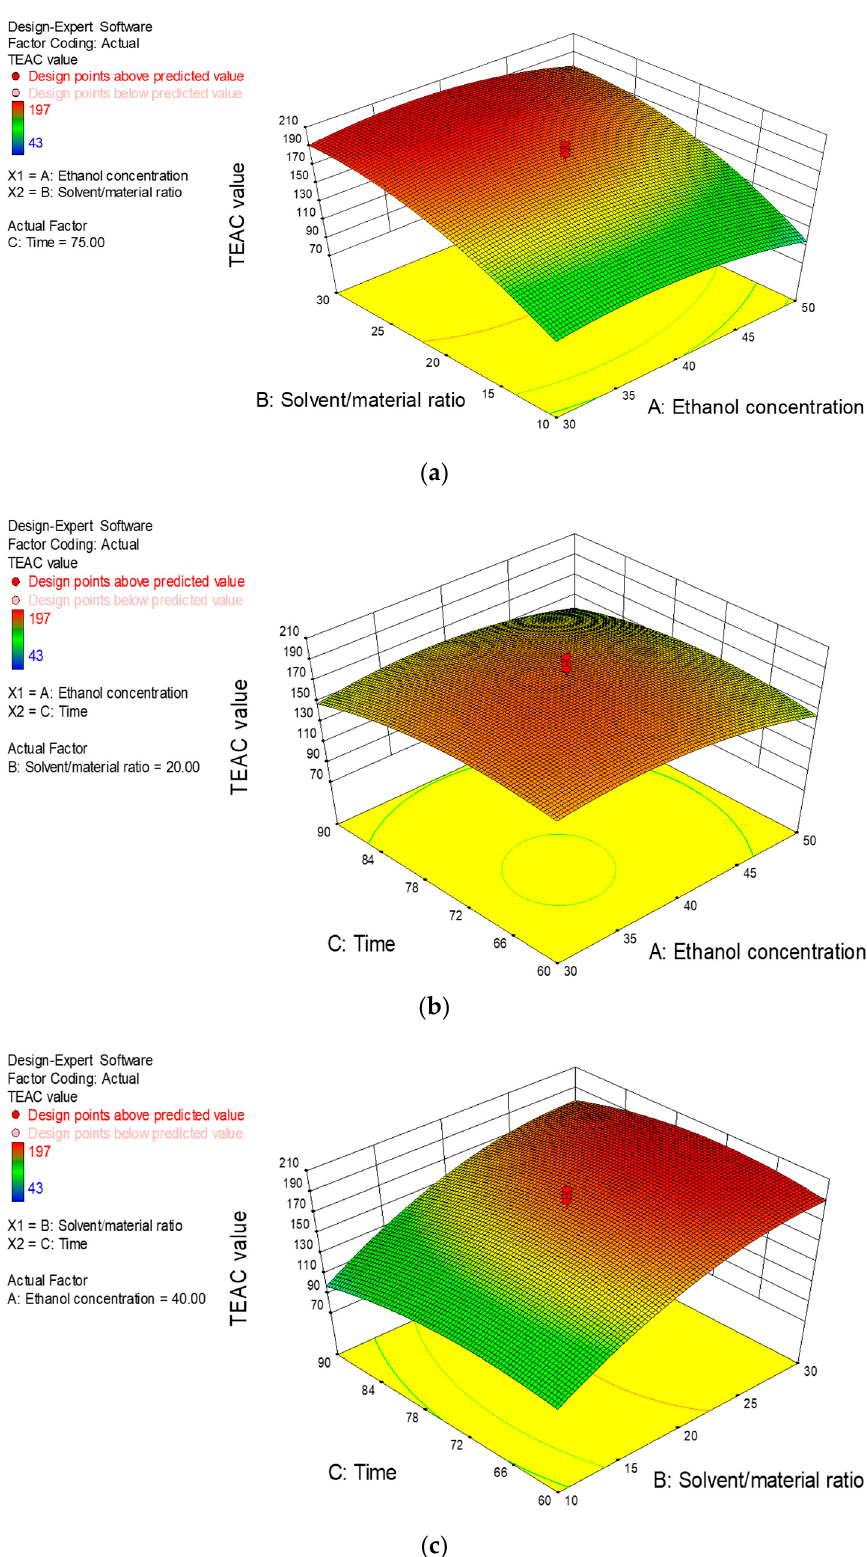
Figure 3. Response surface plots of the effects of ethanol concentration (%) and solvent/material ratio (mL/g) ( a ); ethanol concentration and extraction time (min) ( b ); and solvent/material ratio and extraction time ( c ) on TEAC value (µmol Trolox/g DW).